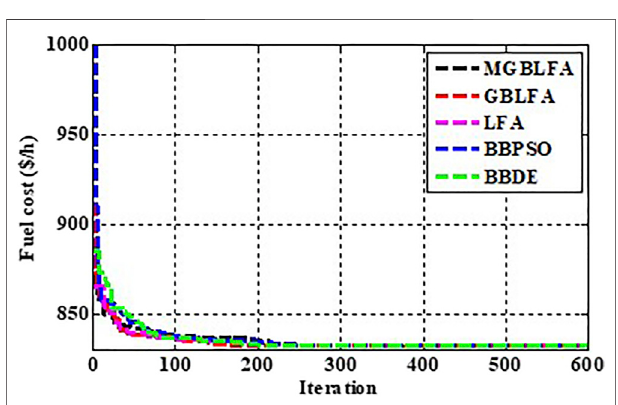
FIGURE 6 | Convergence characteristics of the algorithms for Case